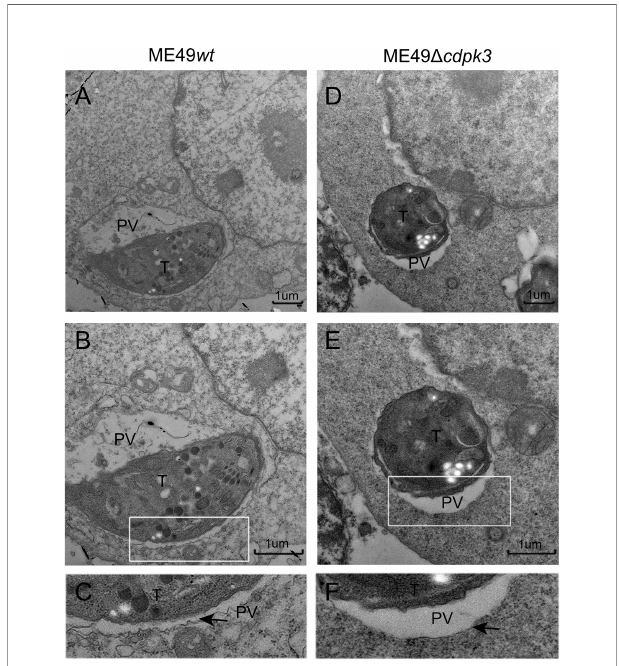
FIGURE 7 | Electron microscopy analysis of the ultrastructural characteristics of parasitic vacuolar membranes in IFN- g -activated RAW264.7 cells. (A – D) Ultrastructural characteristics of parasitic vacuoles in IFN- g (100 U/ml IFN- g , 0.1 ng/ml LPS) activated RAW264.7 infected with ME49 wt or ME49 D cdpk3 parasites. (E, F) A magni fi cation of the PV around parasite in IFN- g activated RAW264.7 shows the highly scalloped appearance of the membrane (marked with a black arrow). Parasitic vacuoles (PV), Toxoplasma gondii (T) (Scale bar:1 m